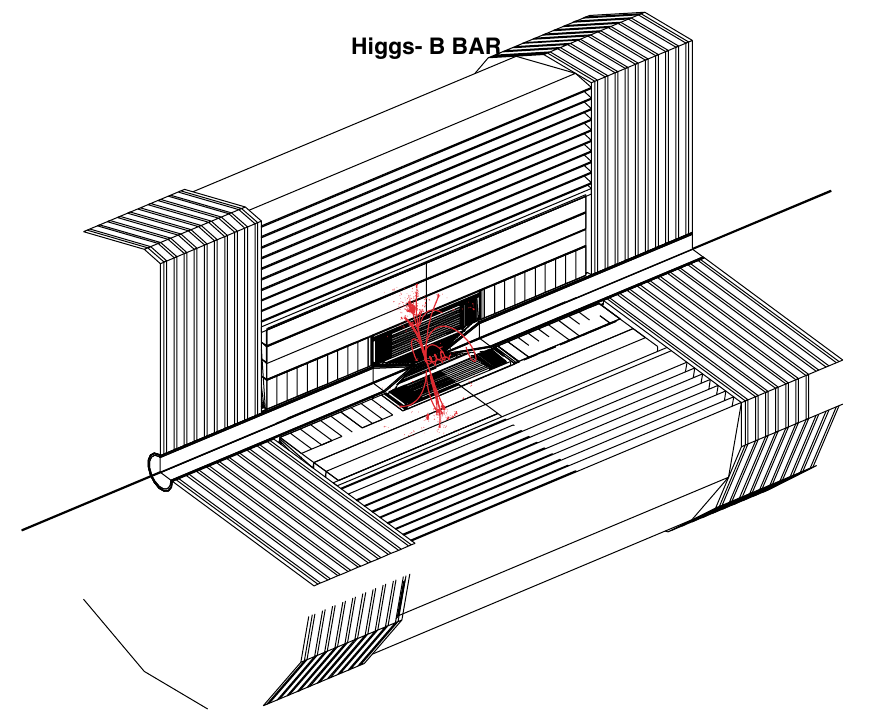
FIG. 45. (Color) Cut view of a straw-man detector in GEANT for the Higgs factory with a Higgs ! b (cid:28) bb event superimposed. No backgrounds shown. The tungsten cones on either side of the interaction region mask out a 20 (cid:28)